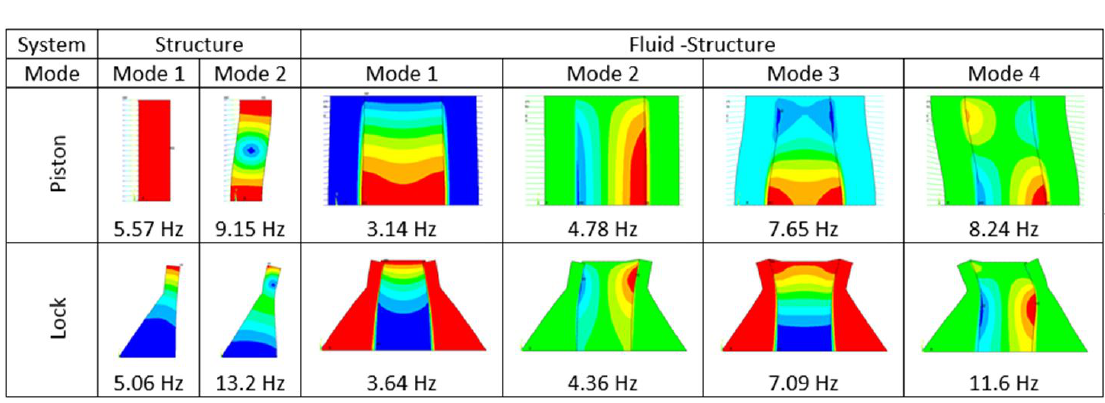
Figure 8. Natural frequencies, in Hz, and numerical vibration modes of the Piston compared to the